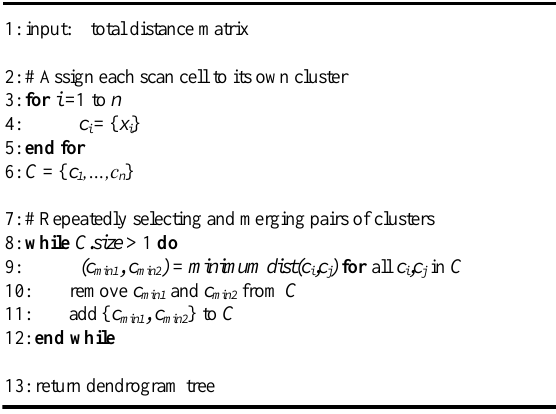
Figure 8. Algorithm for scan correlation clustering.